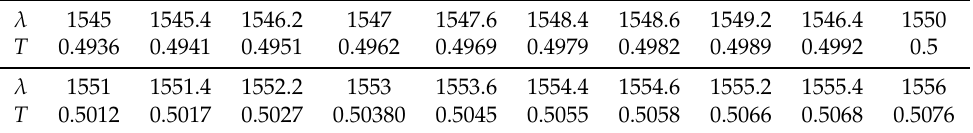
Table 2. The transmittance T at different wavelengths of 50:50 BS with a center wavelength of 1550 nm.